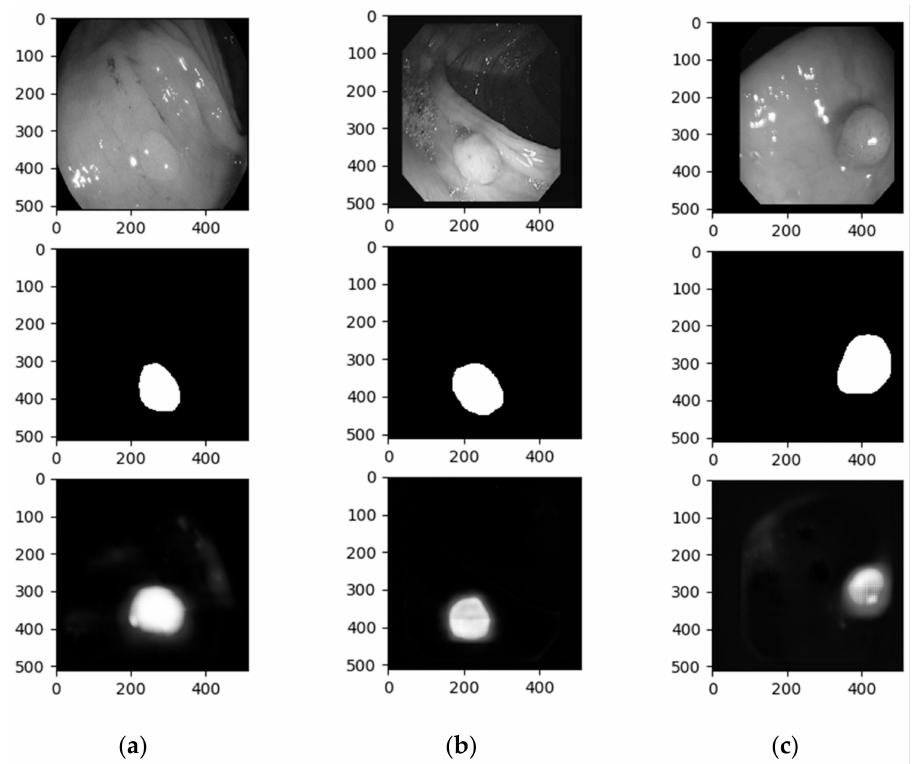
Figure 5. Images showing the results after training the convolutional encoder -decoder model on